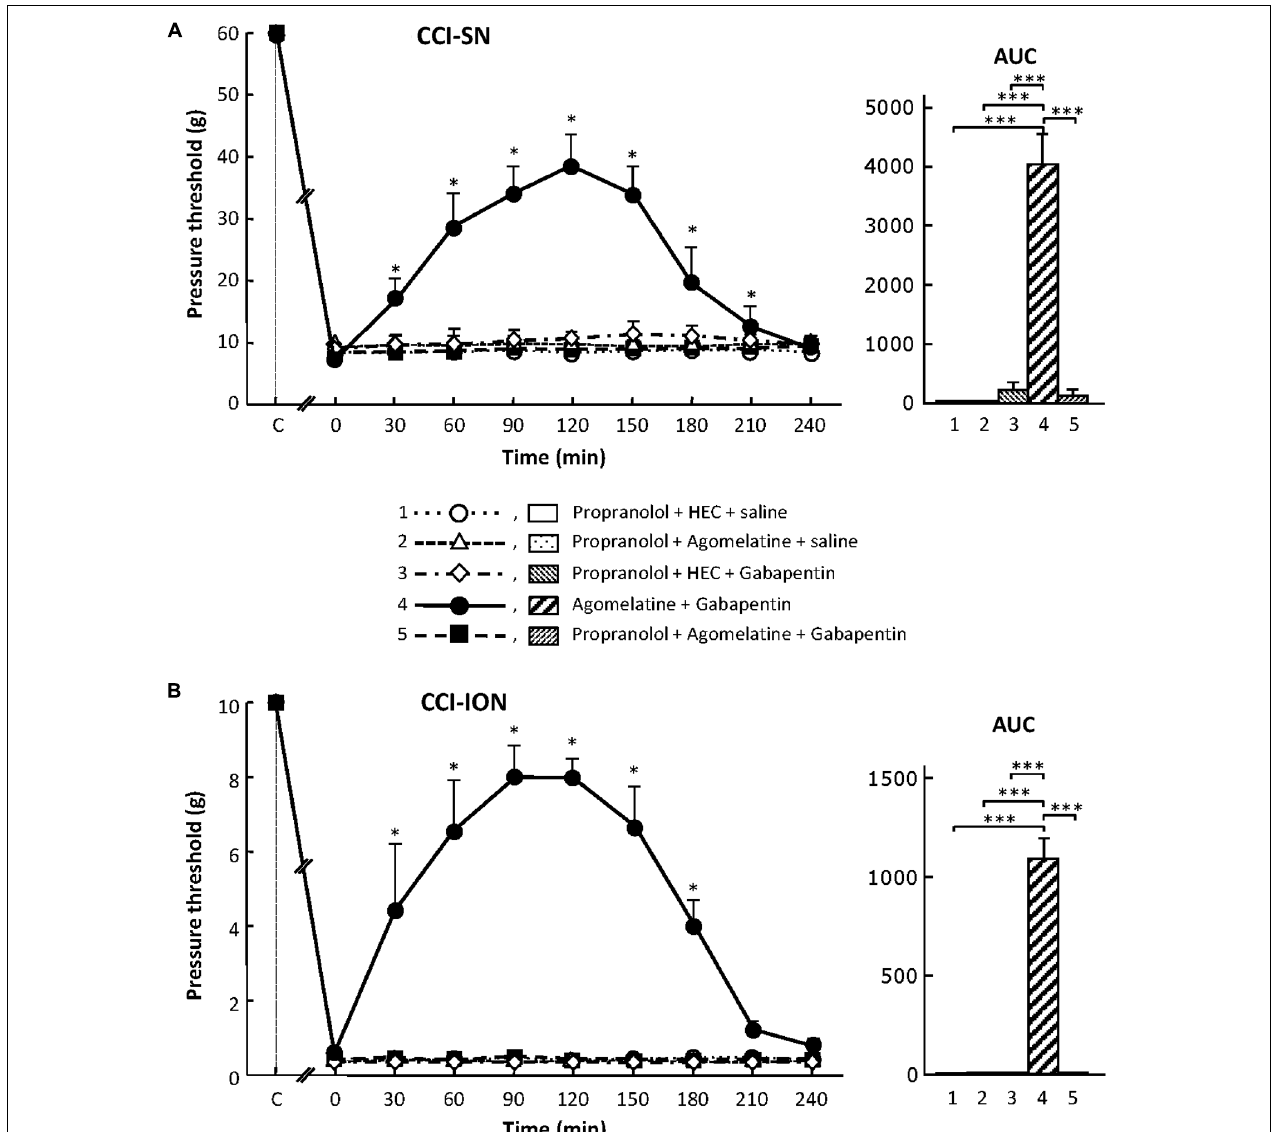
FIGURE 7 | Effects of propranolol alone or co-administered with agomelatine, gabapentin or ‘agomelatine + gabapentin’ on mechanical allodynia in CCI-SN (A) and CCI-ION (B) rats. Left panels: Propranolol (10 mg/kg i.p.) or its vehicle (saline) was administered 30 min before other treatments in rats whose right SN (A) or ION (B) had been ligated 2 weeks before. Five different treatment groups were made: (1) propranolol + HEC + saline, (2) propranolol + agomelatine (45 mg/kg) + saline, (3) propranolol + HEC + gabapentin (50 mg/kg), (4) agomelatine + gabapentin, (5) propranolol + agomelatine + gabapentin. Pressure threshold values (as g) were determined as described in the legend to Figure 1 . Each point is the mean ± SEM of independent determinations in n rats for each condition. ∗ P < 0.05, compared with pressure threshold values determined just prior to treatments (0 on abscissa), one way ANOVA with repeated measures, Dunnett’s test. C on abscissa: intact healthy rats before surgery. In both CCI-SN (A) and CCI-ION (B) rats, ‘saline+HEC’-treated groups were also included, but, for the sake of clarity, corresponding data are not represented as they superimposed with those obtained in rats treated with propranolol + HEC + saline. Right panels: AUC values calculated from the respective time-course curves: (1) propranolol + HEC + saline [ n = 5 (A) /5 (B) ]; (2) propranolol + agomelatine + saline ( n = 5/5); (3) propranolol + HEC + gabapentin ( n = 5/5); (4) agomelatine + gabapentin ( n = 8/7); 5 = propranolol + agomelatine + gabapentin ( n = 14/11). A- CCI-SN : one way ANOVA [ F (4,32) = 73.51, P < 0.0001] followed by Tukey’s test ( ∗∗∗ P < 0.001); B- CCI-ION: one way ANOVA [ F (4,28) = 25.39, P < 0.0001] followed by Tukey’s test ( ∗∗∗ P <